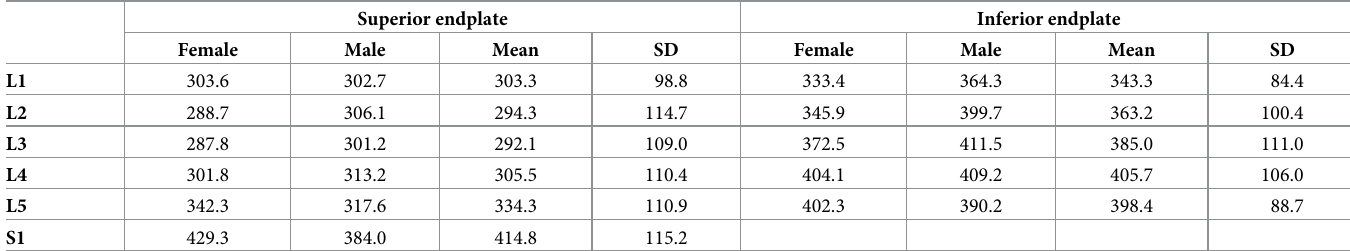
Table 2. Comparison by gender.